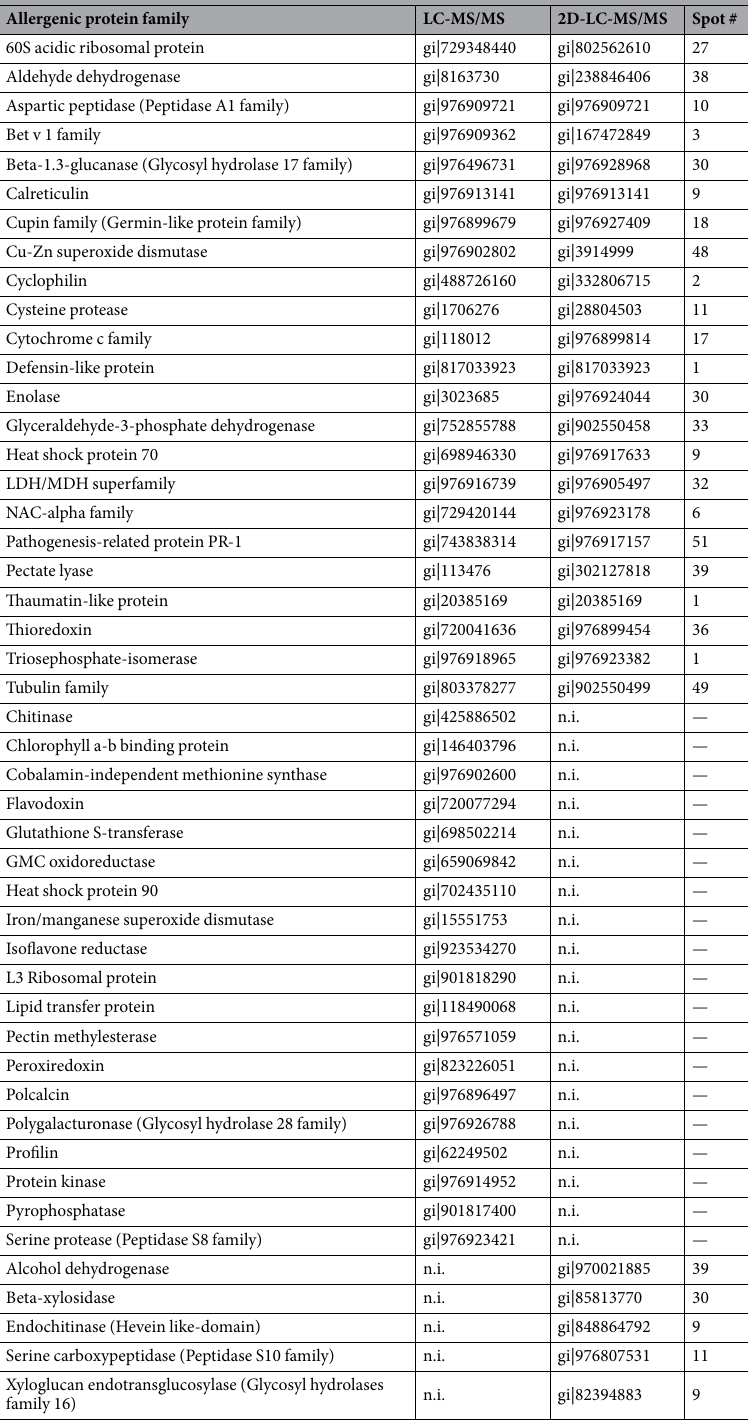
Table 1. Allergenic protein families identified in feverfew pollen by proteomics. n.i., not